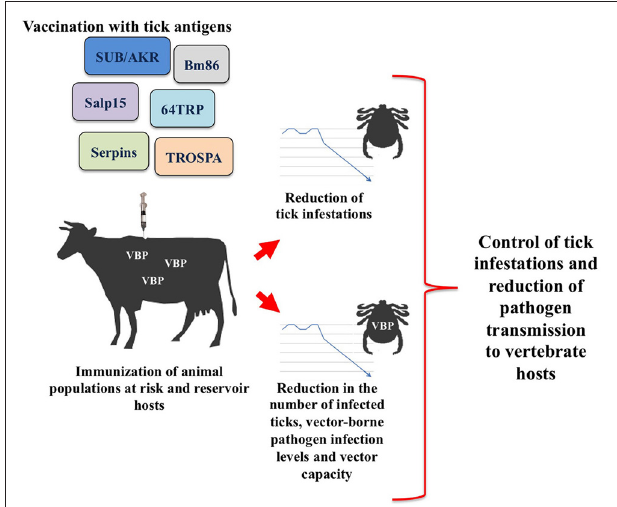
FIGURE 1 | Transmission blocking vaccines based on tick recombinant proteins aim to reduce vector infestations and the infection and transmission of vector-borne pathogens